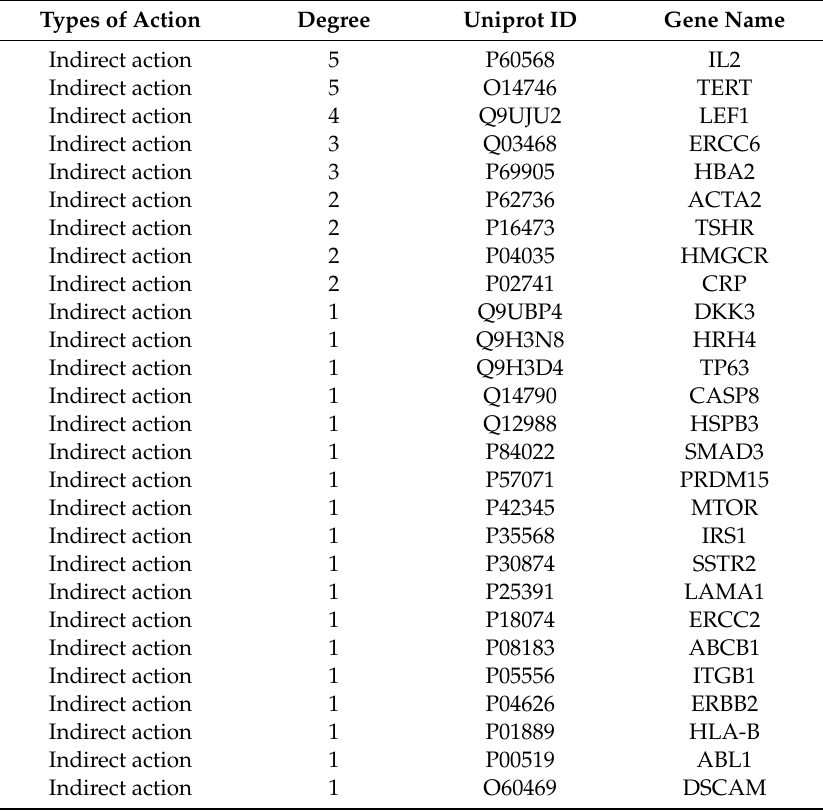
Table 6. Indirect action of 27 LC Therapeutic